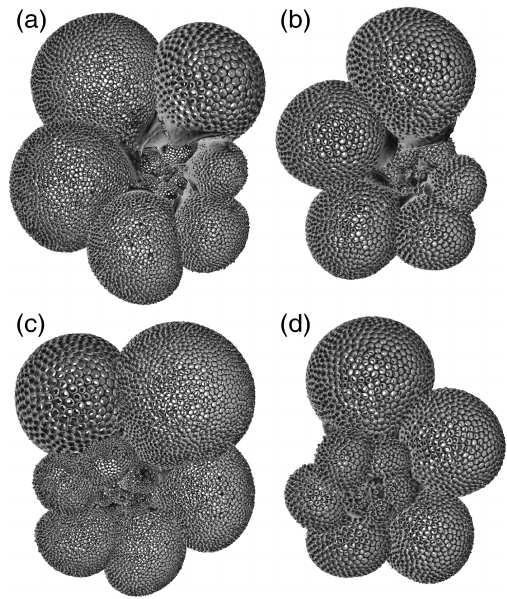
Figure 10. Examples of G. hexagonus tests from tow no. 716 im- aged by micro-CT scan, showing (a) a more porous six-chambered individual recovered deeper in the OMZ and (b) a less porous five-chambered individuals captured shallower in the OMZ. Dorsal views of the same two specimens are shown in (c) and (d) , and both represent typical rather than extreme examples along the continuum of morphological diversity